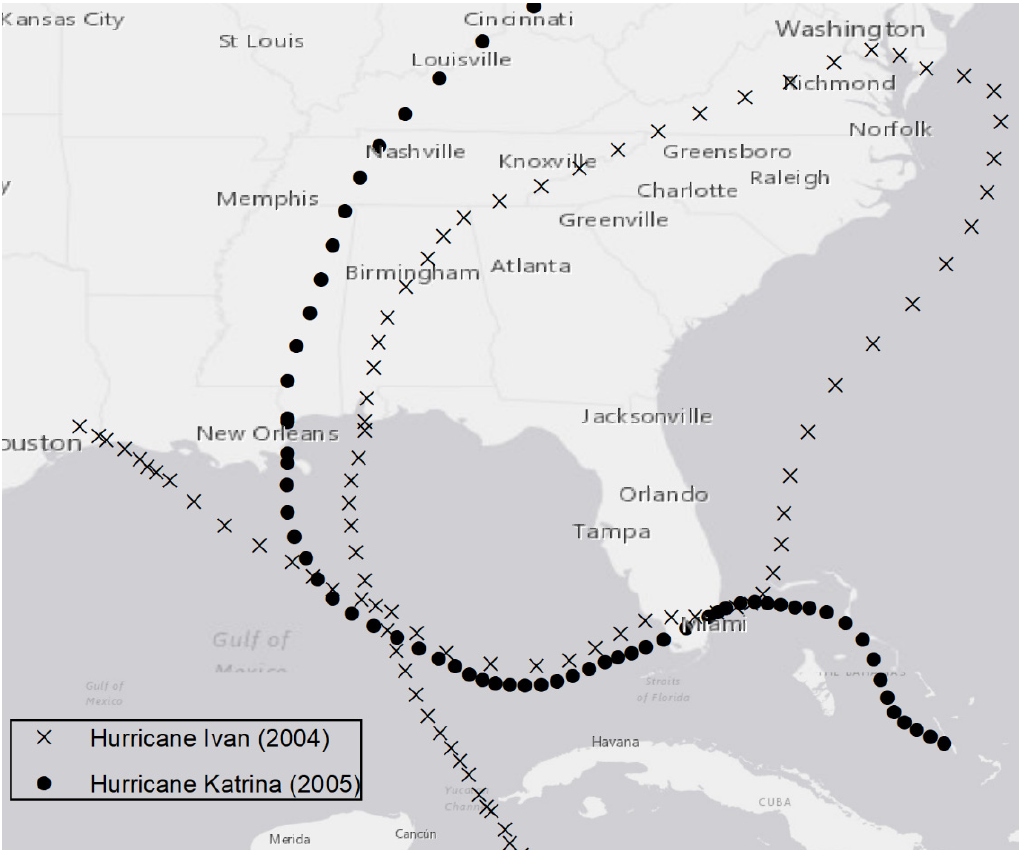
Figure 3. Hurricane Tracks of Ivan and Katrina (Created using ESRI World Topo Base Map). The topographic and bathymetric data were derived from a post-Katrina digital elevation model [57]. This dataset describes the Katrina Cut, i.e., the breach that occurred in the middle of the island after Hurricane Katrina in 2005 (Figure 4, middle transect). Using this data set allows us to simulate the impacts of Hurricane Ivan and Hurricane Katrina under present-day conditions with and without the wave farm. Bed friction coefficients were parameterized using spatially variable Chezy coefficients based on land use/land cover data [56].